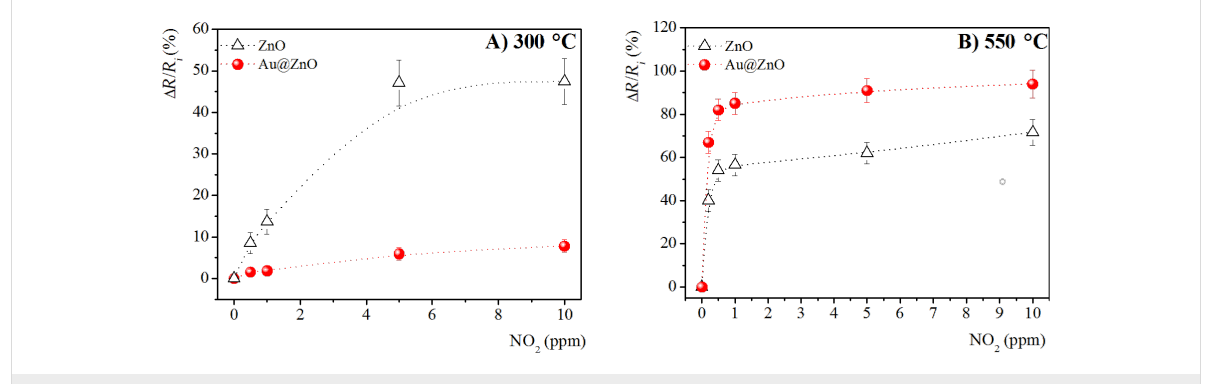
Figure 5: Calibration curves in terms of the percentage relative electrical resistance change for a chemiresistor based on pristine and Au@ZnO annealed at A) 300 °C and B) 550 °C, towards NO 2 gases, at a working temperature of 300 °C.